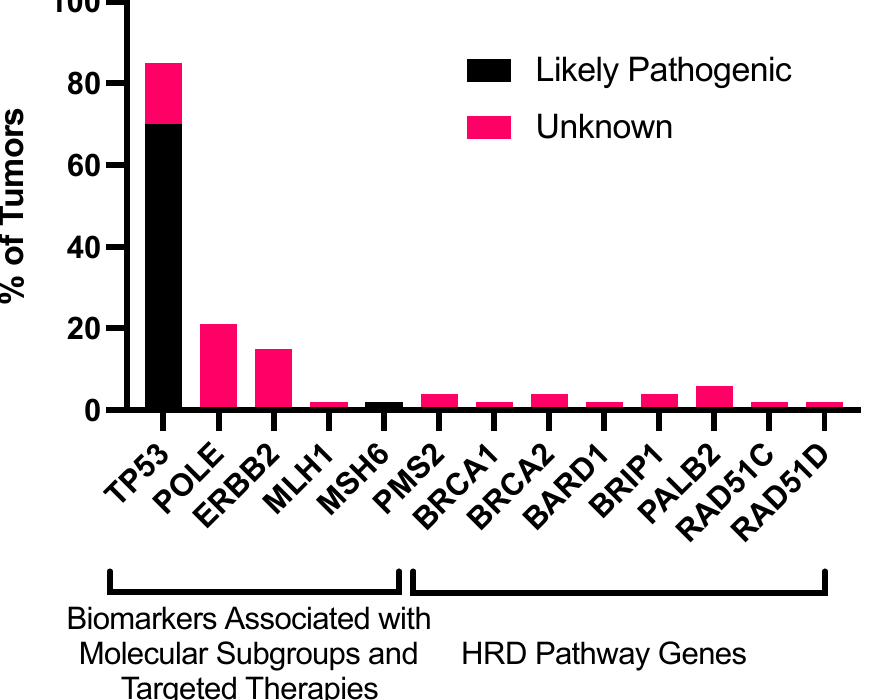
Figure 1. Frequency of mutations in genes associated with molecular classification and other biomarkers (TP53, POLE, ERBB2, and MMR genes) and genes associated with the HRD pathway (BRCA1, BRCA2, PALB2, RAD51C, RAD51D, BRIP1, and BARD1) in uterine serous cancers. This analysis includes point mutations, insertions, deletions, and rearrangements. Unknown mutations were mutations with unknown pathogenic significance. Abbreviations: HRD, homologous recombination deficiency.